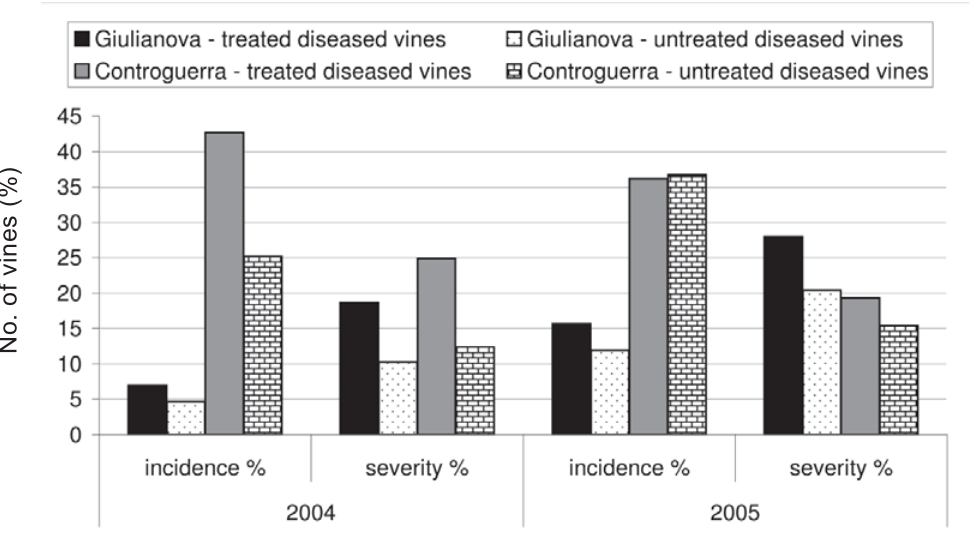
Fig. 2. Incidence and severity of foliar symptoms on vines affected with esca proper treated with nutrients and bioactivators, and untreated